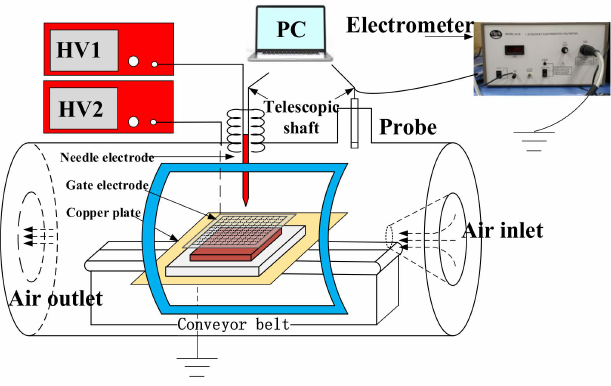
Figure 12. Surface charge test system for insulating media in an airflow